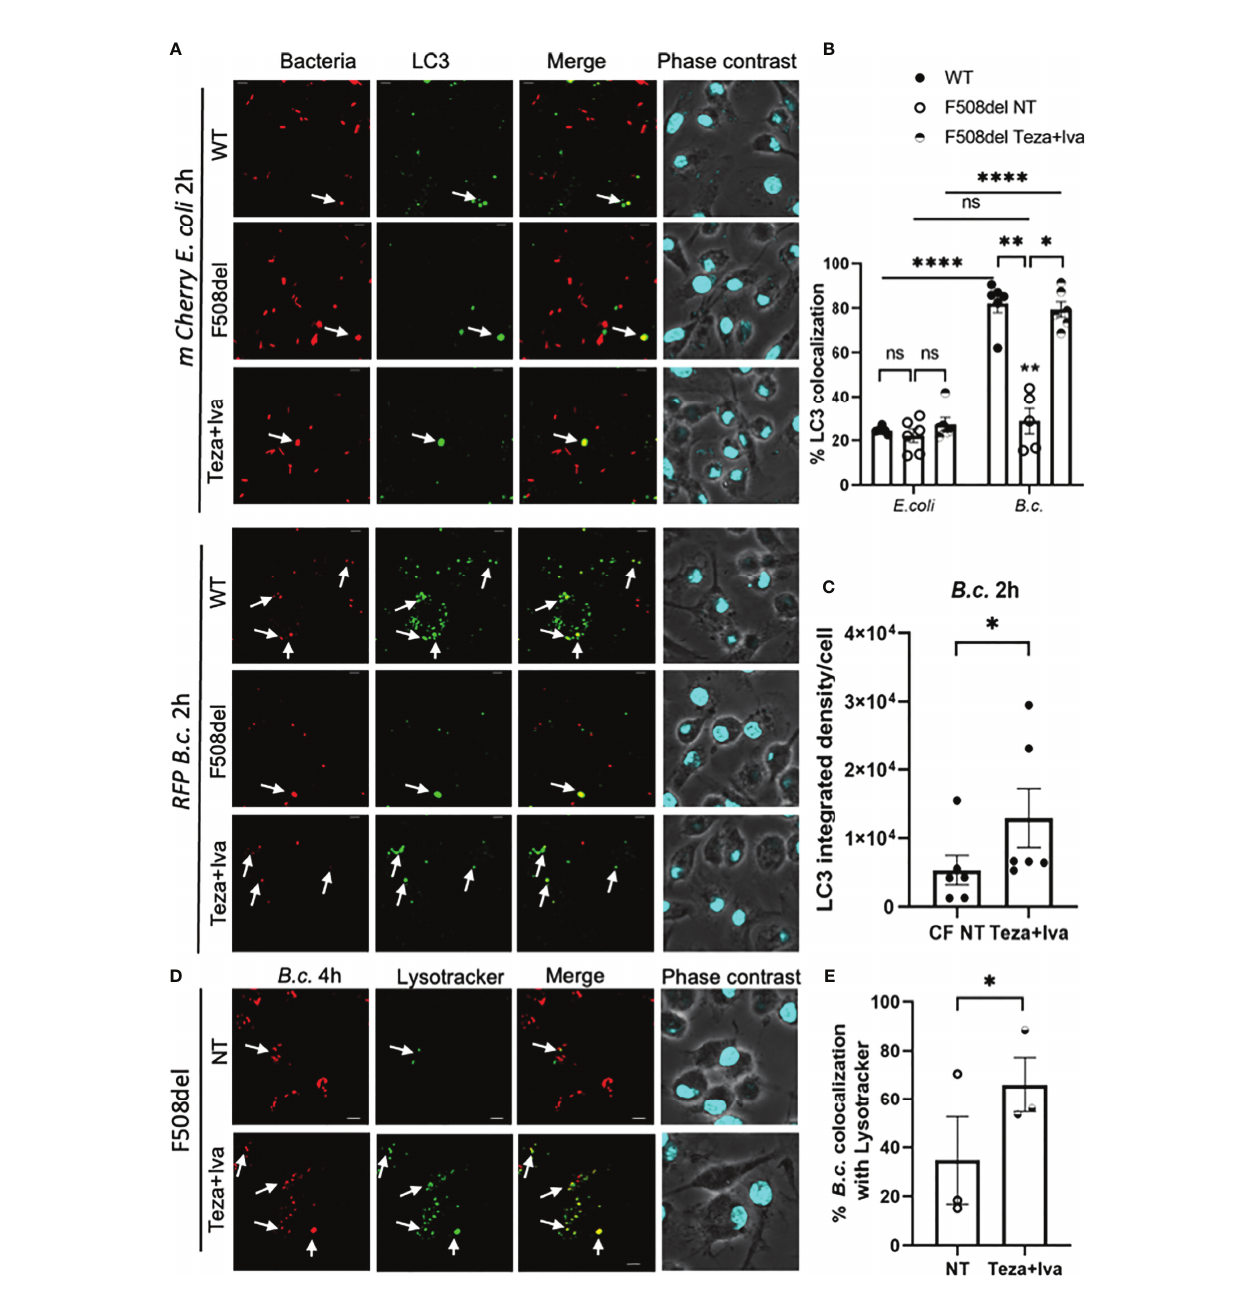
FIGURE 8 | CFTR modulators enhance Burkholderia cenocepacia but not Escherichia coli delivery to autophagosomes in F508del macrophages. (A) LC3 immuno fl uorescence assay of m-Cherry E. coli and RFP B. c.- infected mouse wild-type (WT) and F508del macrophages for 2 h. F508del macrophages were either non- treated (NT) or treated with Teza+Iva for 24 h (representative n = 3 biological replicates). Scale bar = 5 µm. White arrows point to bacteria-LC3 colocalization. (B) % bacteria colocalized with LC3 at 2 h post-infection shown in panel (A) Data represent mean ± SEM calculated by scoring 5 randomly chosen fi elds of view with approximately 200 cells from 3 independent experiments. Statistical analysis was performed using two-way ANOVA; * p ≤ 0.05; ** p ≤ 0.001; **** p ≤ 0.0001; ns, non-signi fi cant. (C) LC3 integrated density in F508del macrophages NT or treated with Teza+Iva for 24 h, followed by B. c . infection for 2 h. Data represent mean ± SEM calculated using ImageJ software 5 from randomly chosen fi elds of view with approximately 200 cells from 3 independent experiments. Statistical analysis was performed using Student ’ s paired t-test; * p ≤ 0.05. (D) LysoTracker Green immuno fl uorescence assay of RFP B. c.- infected F508del macrophages for 4 h. Macrophages were either NT or treated with Teza+Iva for 24 h (n = 3 biological replicates). Scale bar = 5 µm. White arrows point to B. cenocepacia -LysoTracker colocalization. (E) % B. c. colocalized with LysoTracker green at 4 h post-infection shown in panel (C) Data represent mean ± SEM calculated by scoring at least 5 randomly chosen fi elds of view with more than 200 cells from 3 independent experiments, colocalized RFP B.c. normalized to the total number of RFP B.c . Statistical analyses were performed using Student ’ s t-test; * p ≤